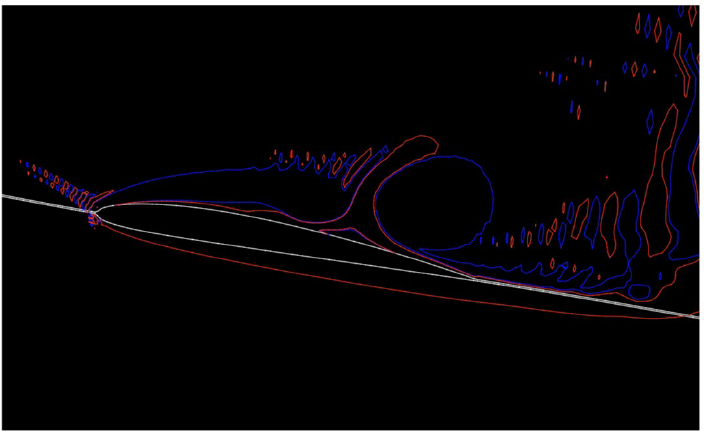
Figure 13. Instantaneous vorticity contours around NACA2408 airfoil at angle of attack of 8 ◦ and Re =